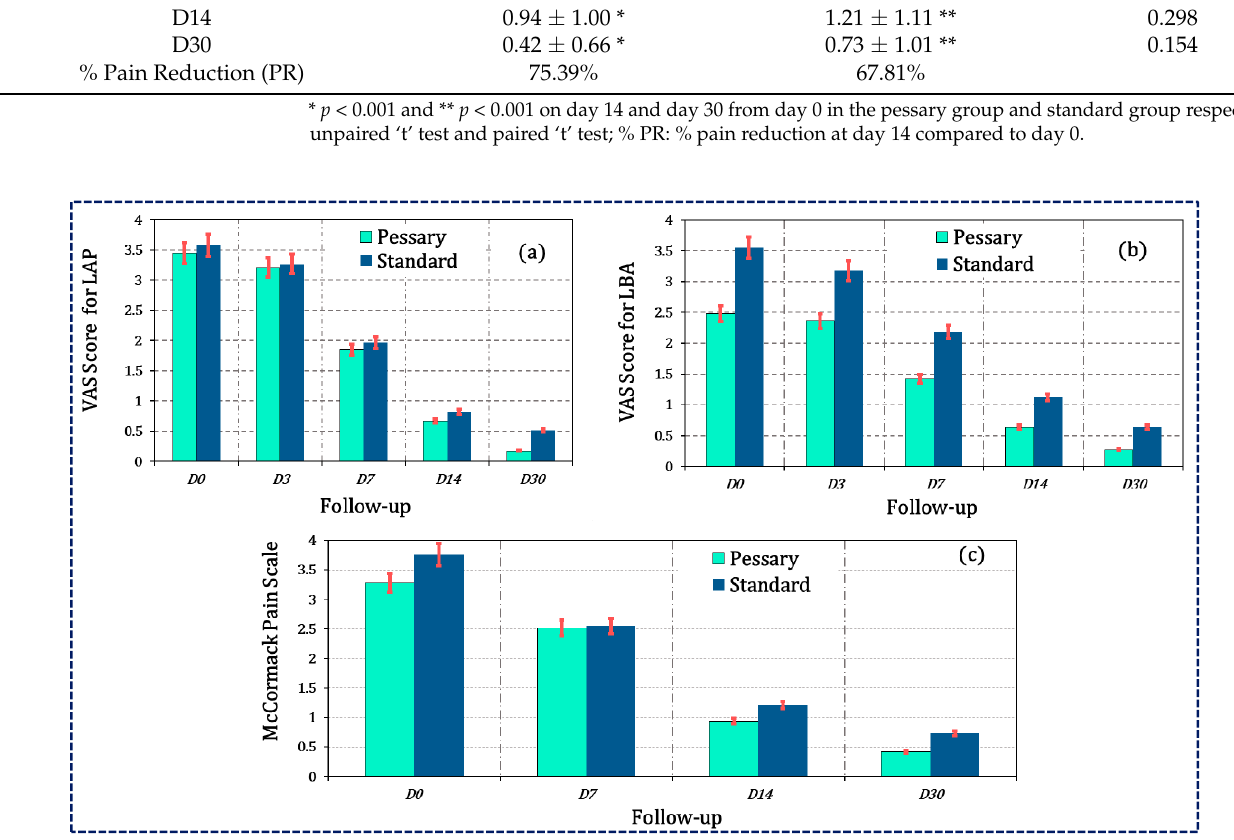
Figure 3. Graphical depiction of ( a ) VAS score for LAP, ( b ) VAS score for LBA, and ( c ) McCormack pain scale for pelvic tenderness.